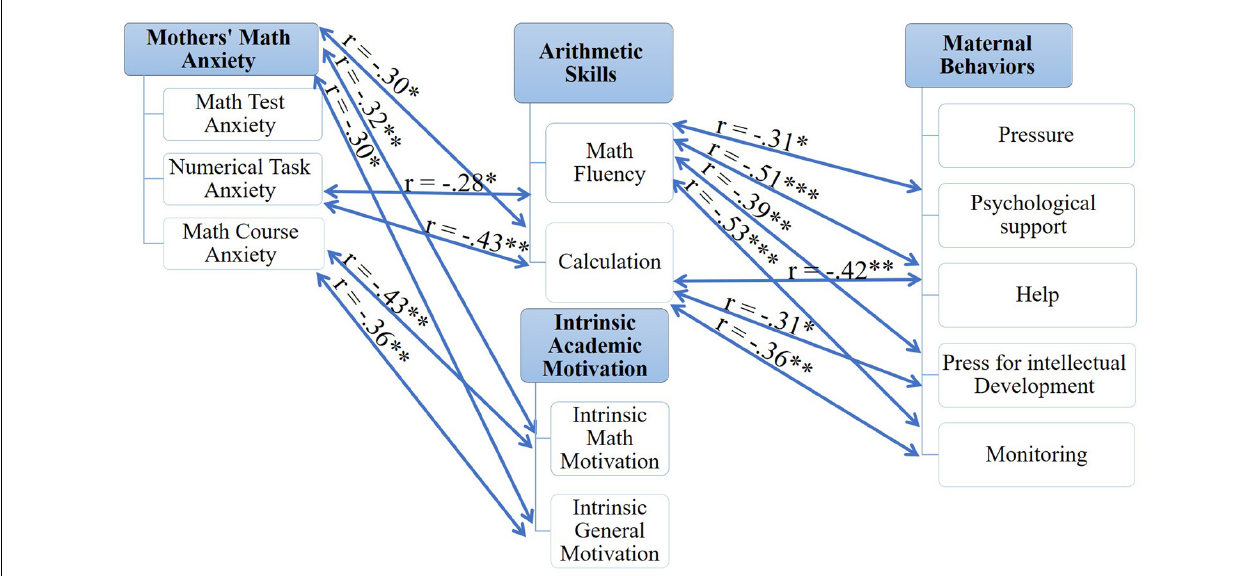
FIGURE 5 | A schematic summary of the correlations between mothers’ variables and children’s arithmetic skills and intrinsic academic motivation. ∗ p ≤ 0.07, ∗∗ p < 0.05, ∗∗∗ p < 0.01 (one-tailed).